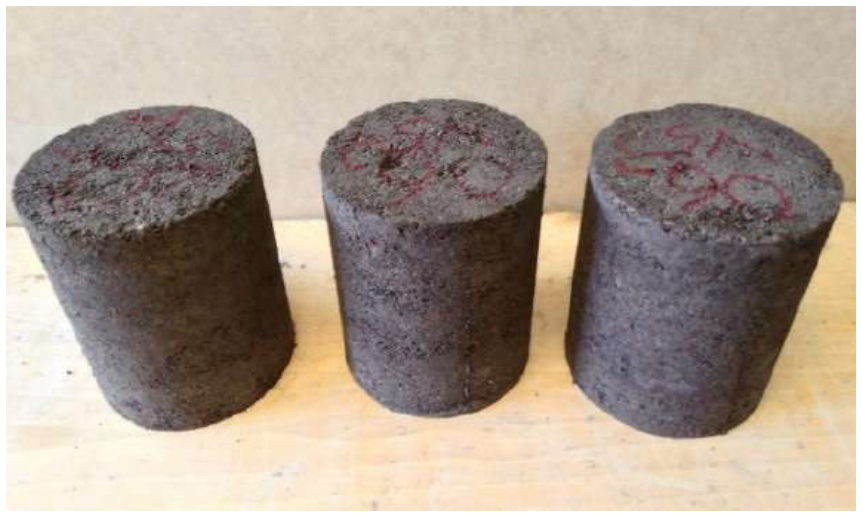
Figure 2. Example of three compacted specimens of CTS.